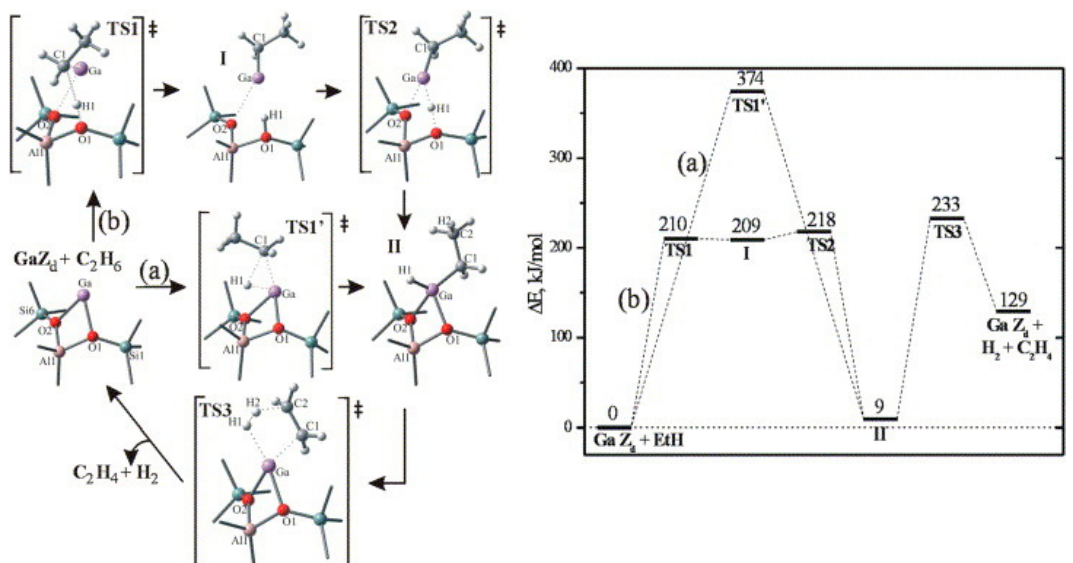
Figure 14. Homolytic ( a ) and heterolytic ( b ) “alkyl” pathways of ethane dehydrogenation over Ga + Z d site. Reprinted with permission from ref [113]. Copyright 2006 Elsevier.